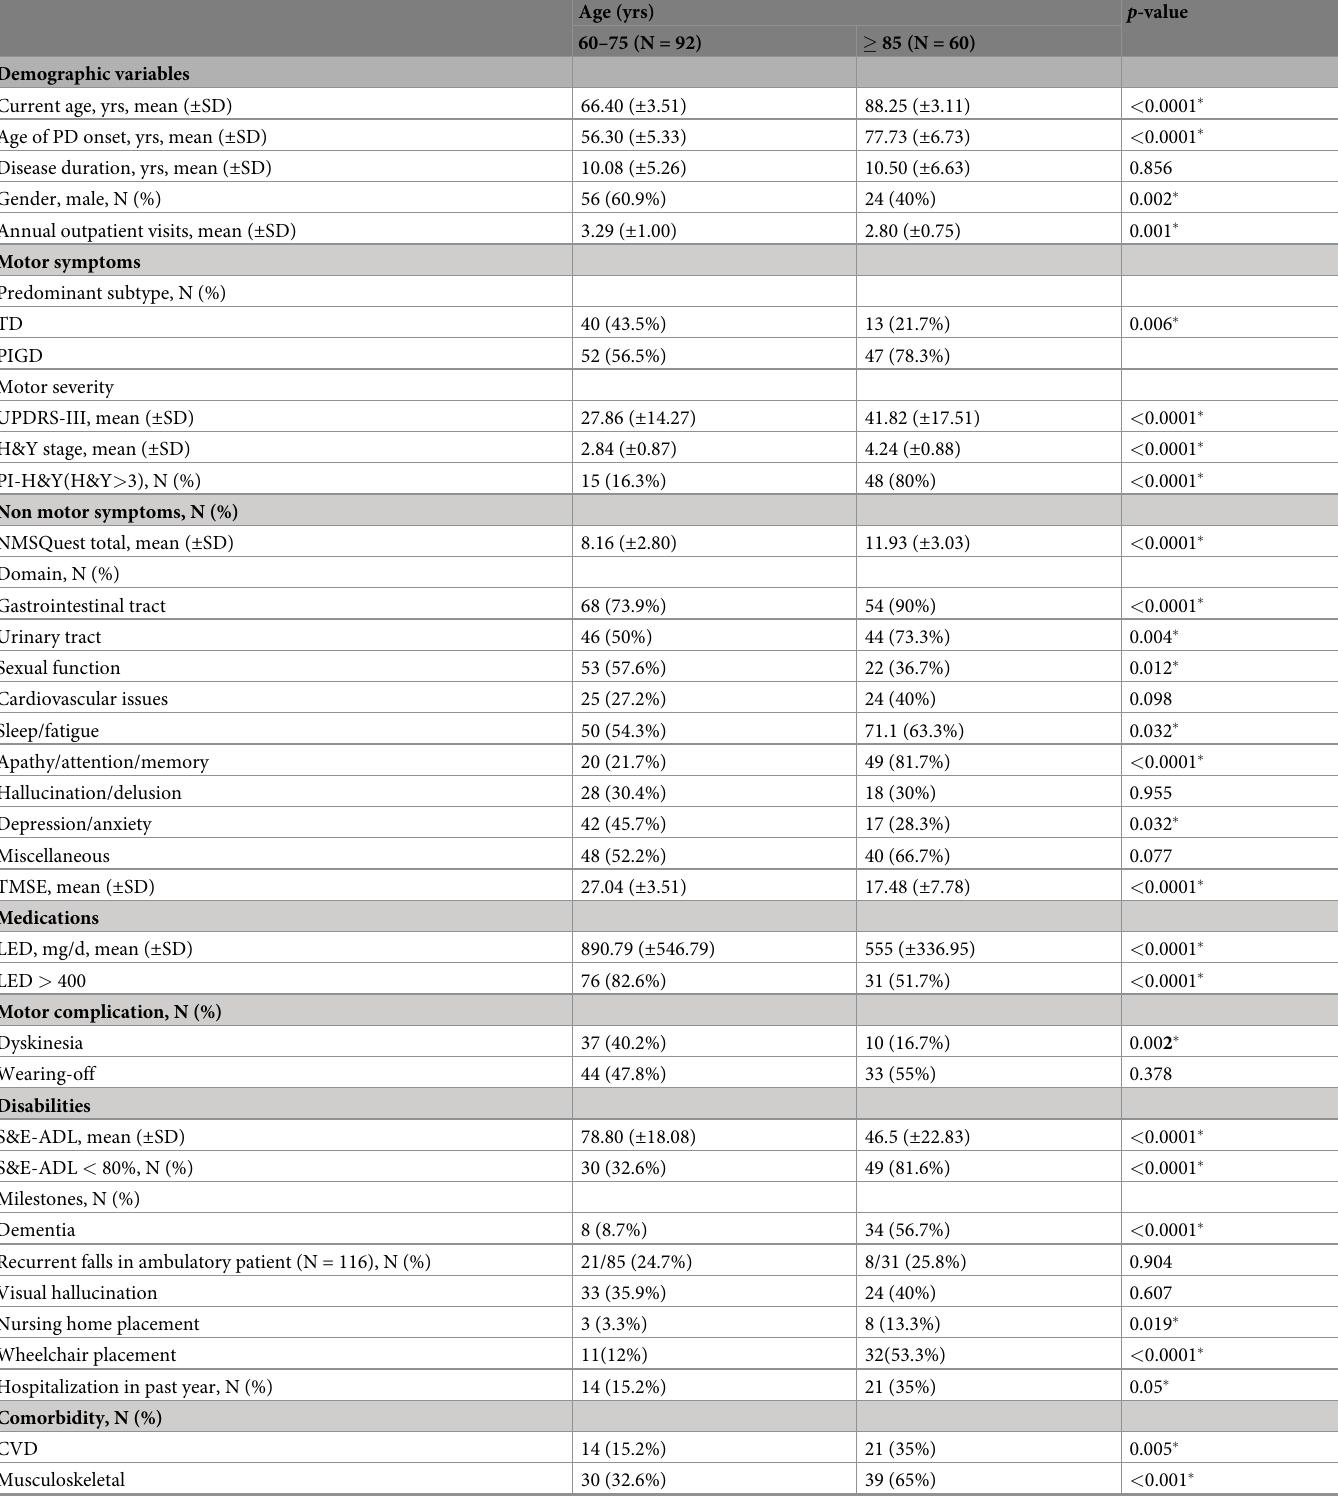
Table 1. Comparison of demographic and clinical characteristics of old-old versus young-old PD